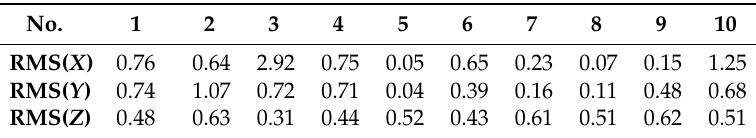
Table 2. Standard deviation of the 3rd floor positioning